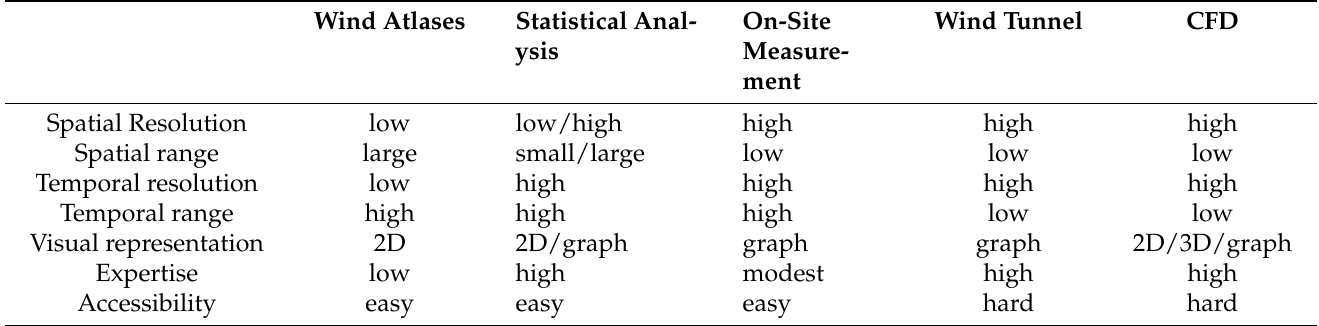
Table 1. An overview of characteristics of the different wind energy assessment